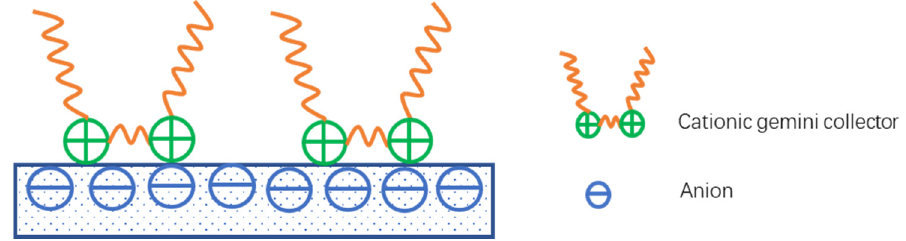
Figure 6. Schematic model of a cationic gemini collector adsorption at the quartz surface.